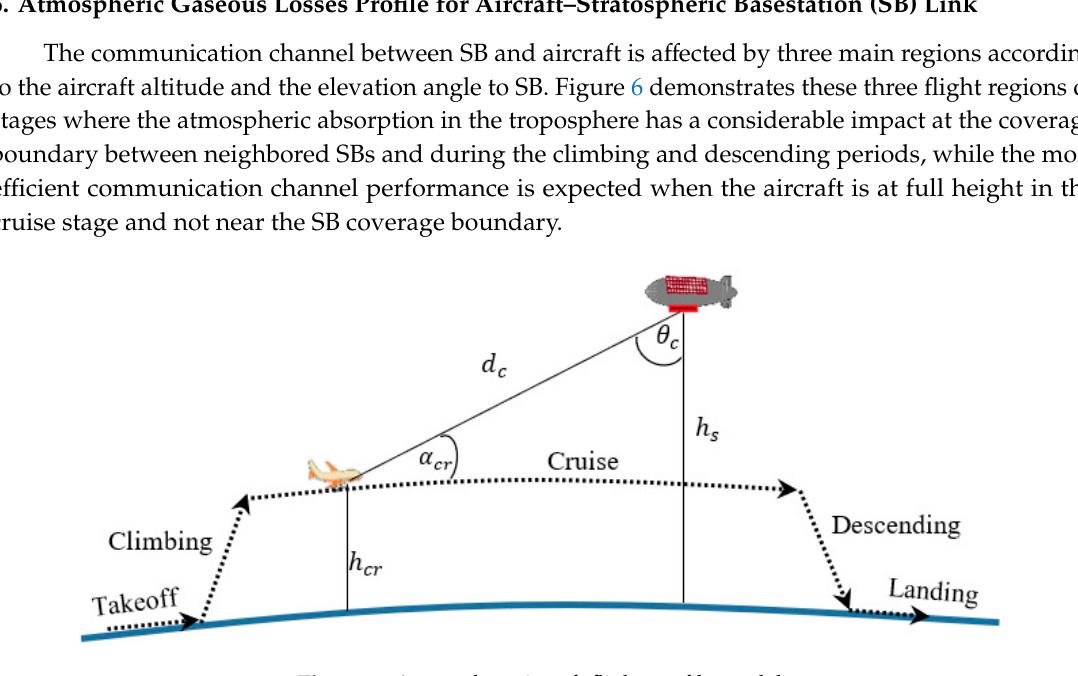
Figure 6. A complete aircraft flight profile model.